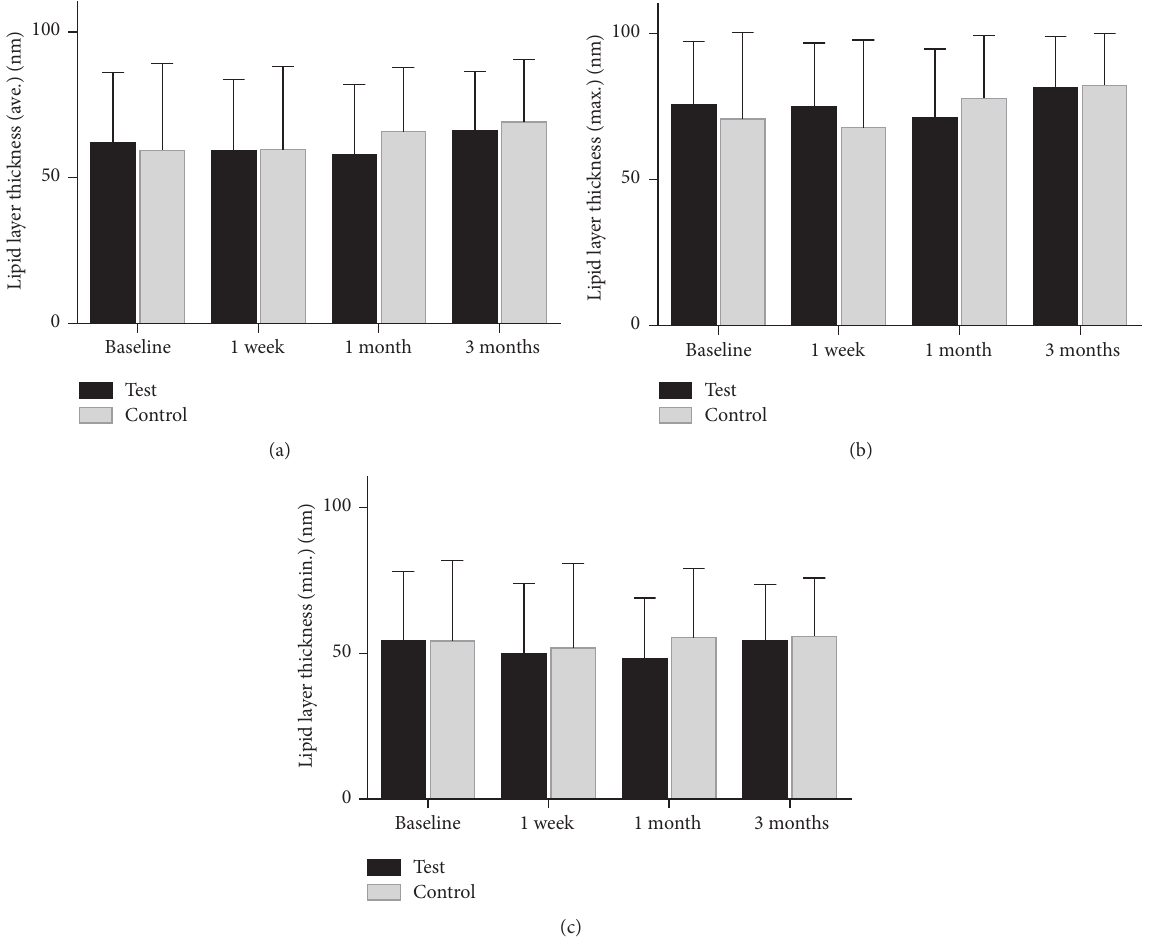
Figure 3: The mean value of test-eye lipid layer thickness (LLT) at baseline, at one week, at one month, and at three months. (a) The average of LLT. (b) The maximum of LLT. (c) The minimum of